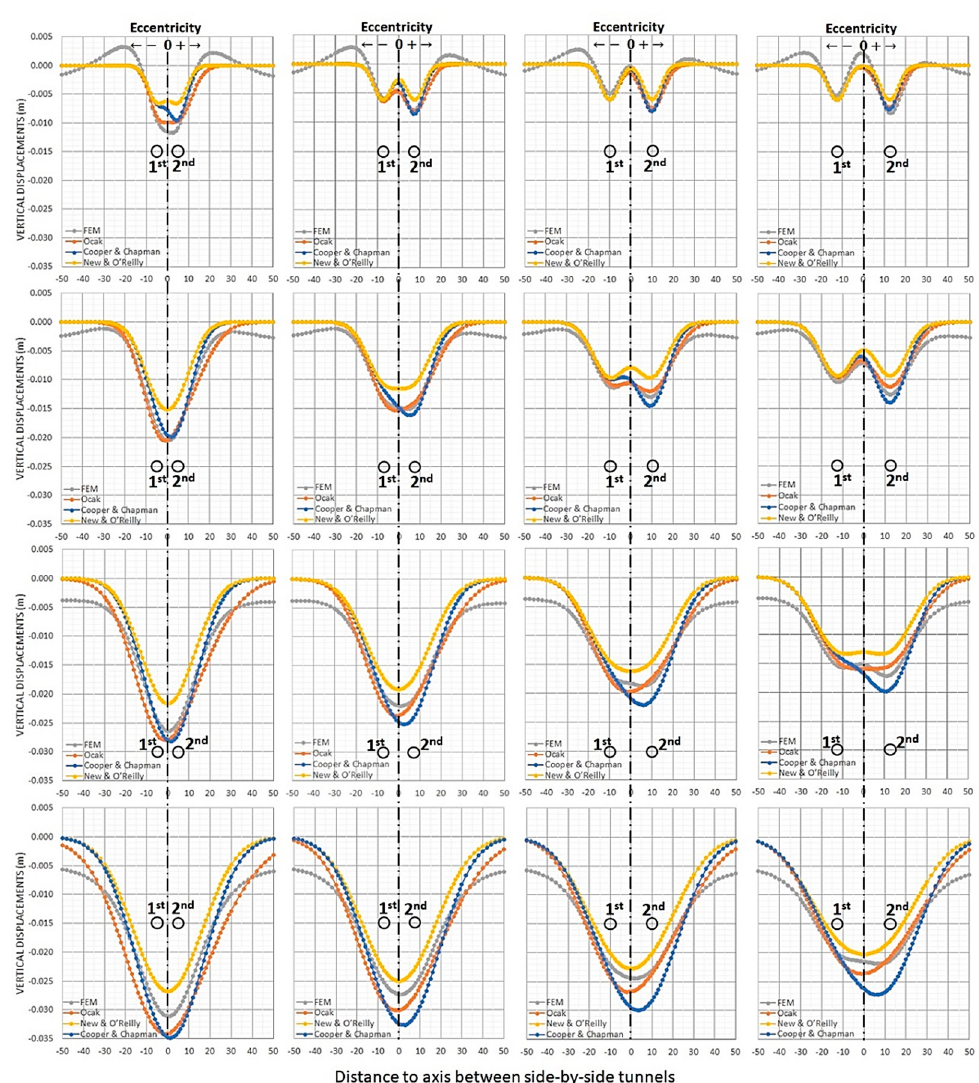
Figure 8. Settlement troughs for the different methodologies.